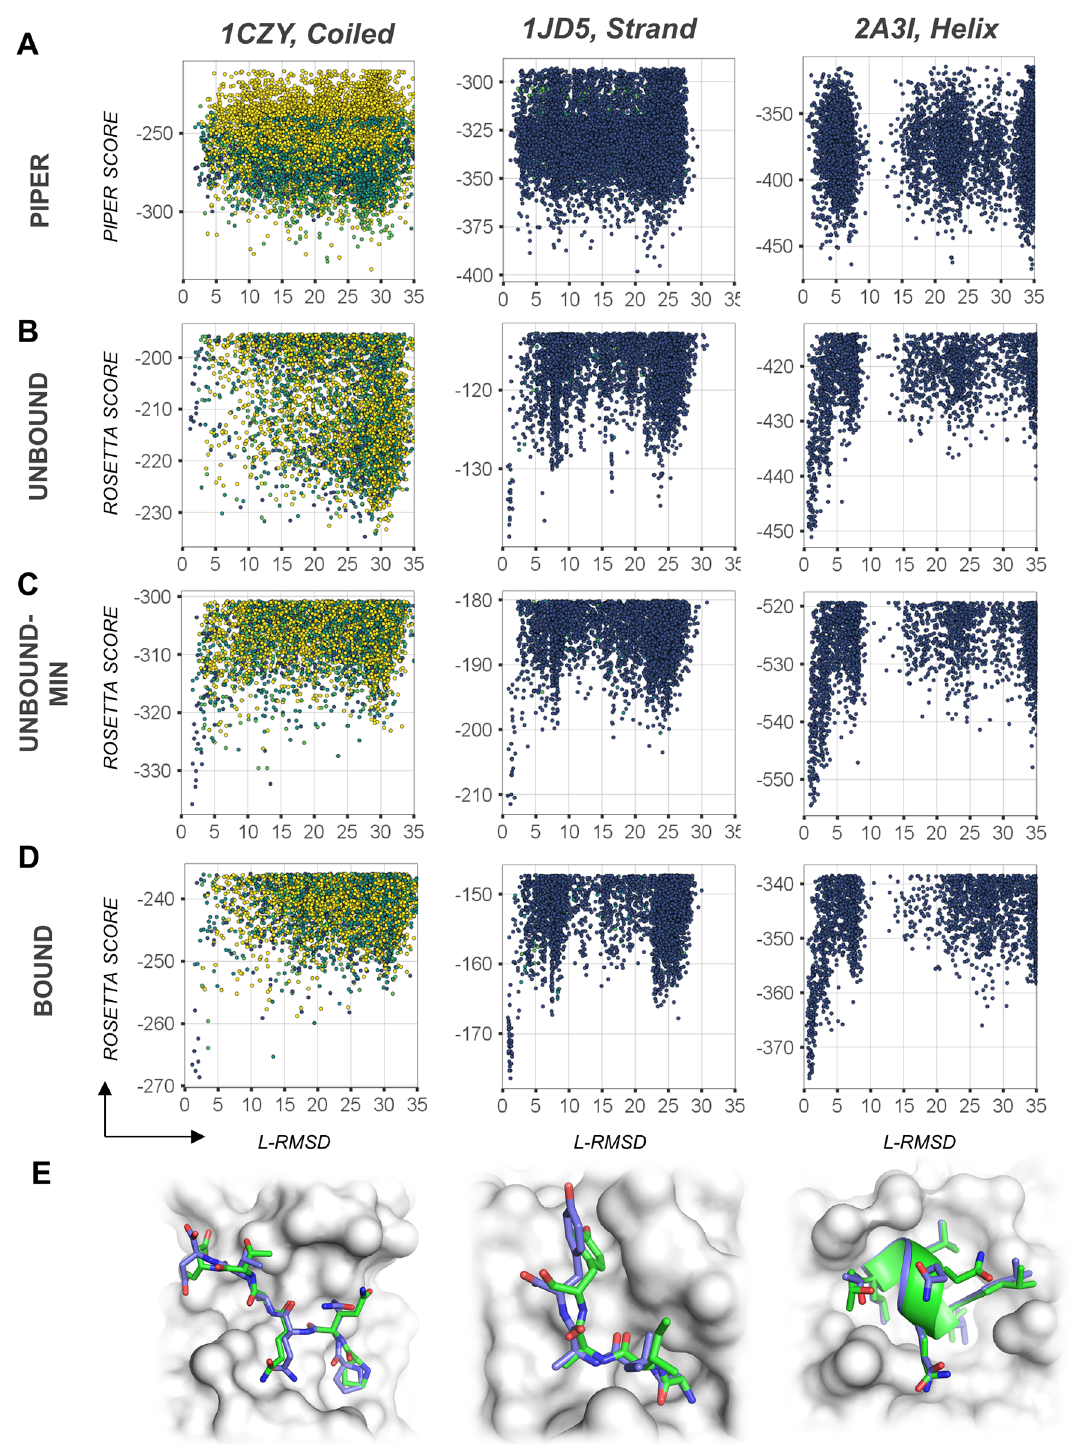
Fig 3. Examples of global peptide docking energy landscapes. Left: PDB id 1CZY (coiled peptide); Center : 1JD5 (extended peptide); Right: 2A3I (helical peptide). (A) Energy landscape as sampled in the first docking step of the protocol by PIPER rigid body docking of peptide fragments onto the unbound receptor structure. (B-D) Energy landscapes for the PIPER-FPD scheme, starting from the unbound receptor structure (B) , the unbound receptor structure including receptor flexibility (C) , and the corresponding bound receptor for comparison (D) . Models are colored according to fragment quality, as in previous Figures. (E) Comparison of the modeled to the native structure (shown in blue and green, respectively).